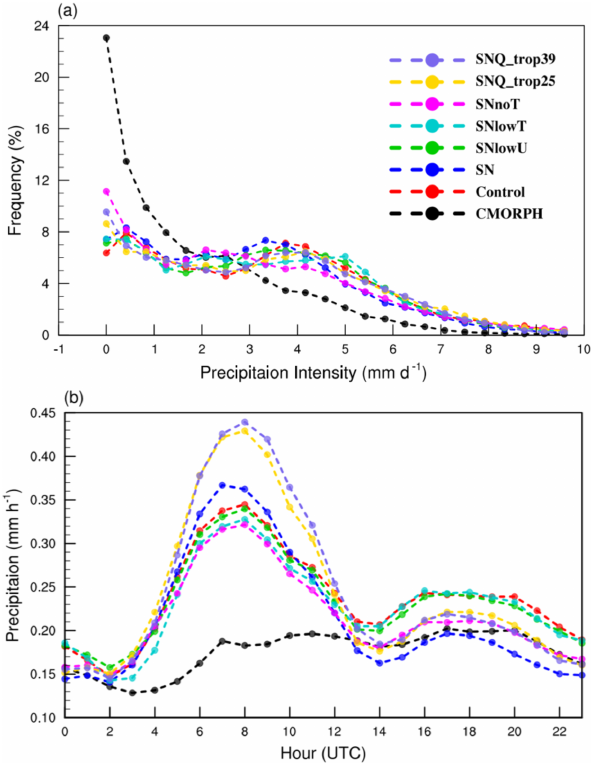
Figure 5. (a) The frequency distribution of mean precipitation in- tensity (mmd − 1 ) for CMORPH and simulated precipitation of July over the TP. (b) The average diurnal cycle of precipitation (mmh − 1 ) over the